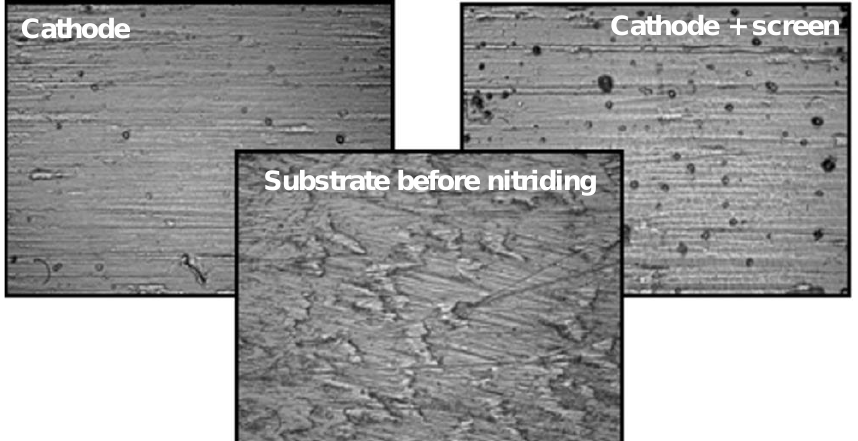
Figure 12. Microphotographs of the surface condition of Grade 5 titanium before and after nitriding in various areas of the glow discharge.